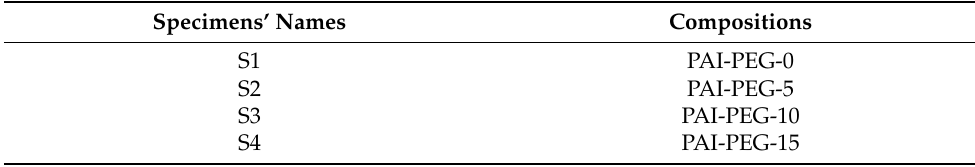
Figure 2. The synthesis of Poly(amide-imide)-polyethylene glycol copolymer(PAI-PEG). Table 1. Different samples’ names and Table 1. Different samples’ names and compositions.